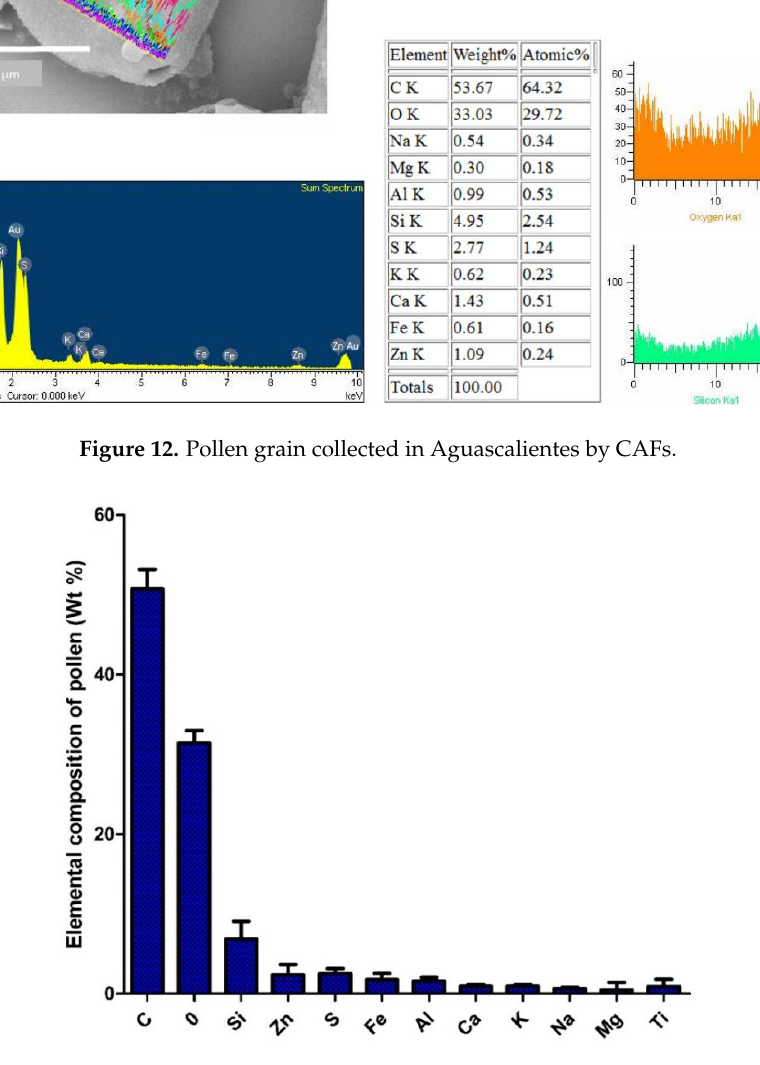
Figure 13. Frequency of elements in the composition of pollens collected by